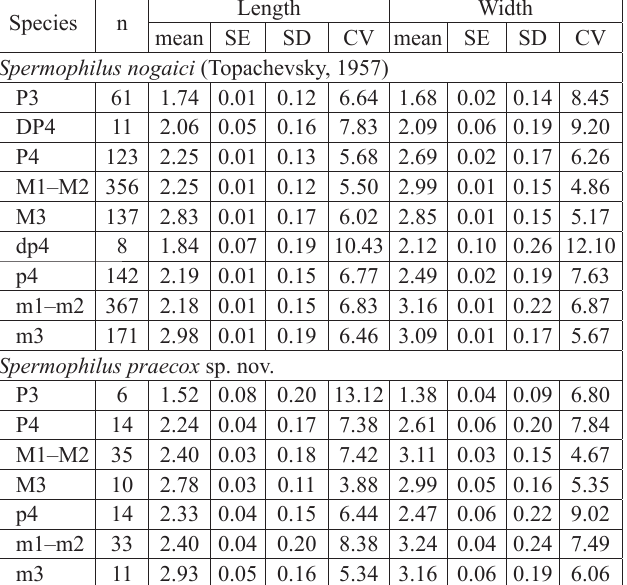
Table 3. Summary statistics and dental measurements (in mm) of Sper- mophilus nogaici (Topachevsky, 1957) and S. praecox sp. nov. CV, coefficient of variation; SD, standard deviation; SE, standard